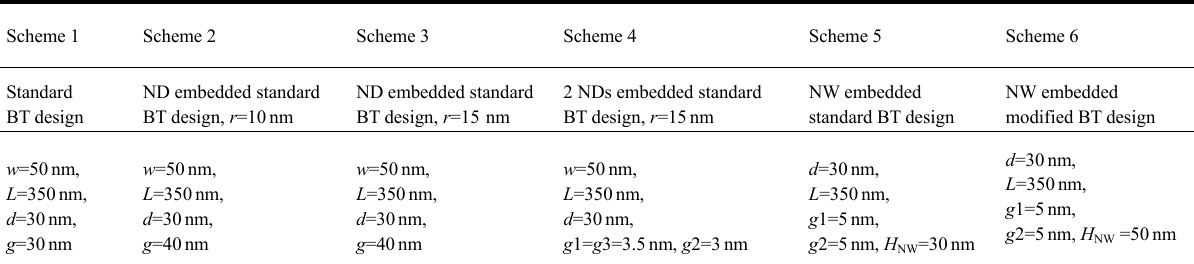
Table 2 Geometric parameters of the BT